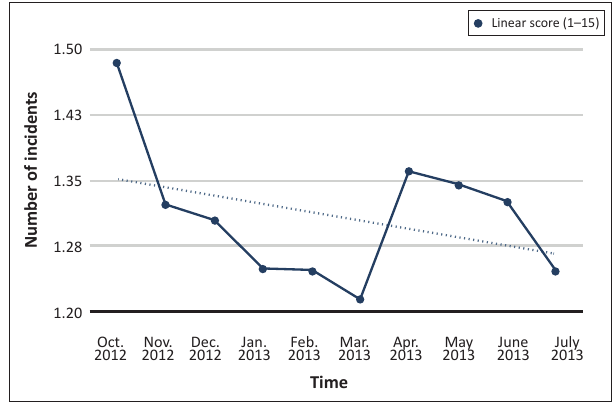
TABLE 2: Summary of fleets in which risky driver behaviour was assessed. Description